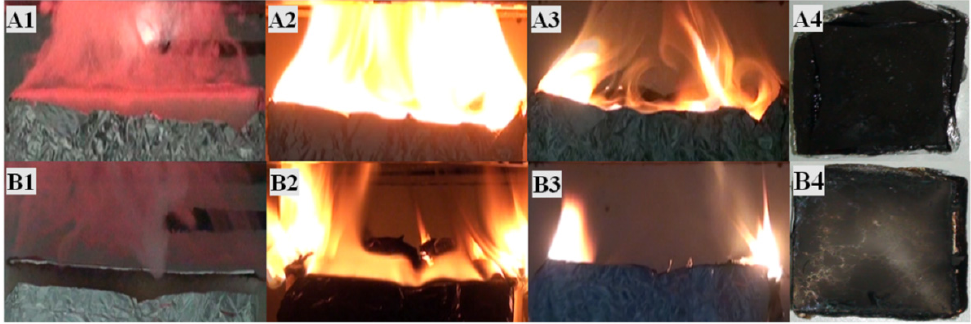
Figure 8. Four stages of the burning behavior of material A and B. ( A1 ) Ignition; ( A2 ) Flashover; ( A3 ) Decay; ( A4 ) Extinction; ( B1 ) Ignition; ( B2 ) Flashover; ( B3 ) Decay; ( B4 ) Extinction.